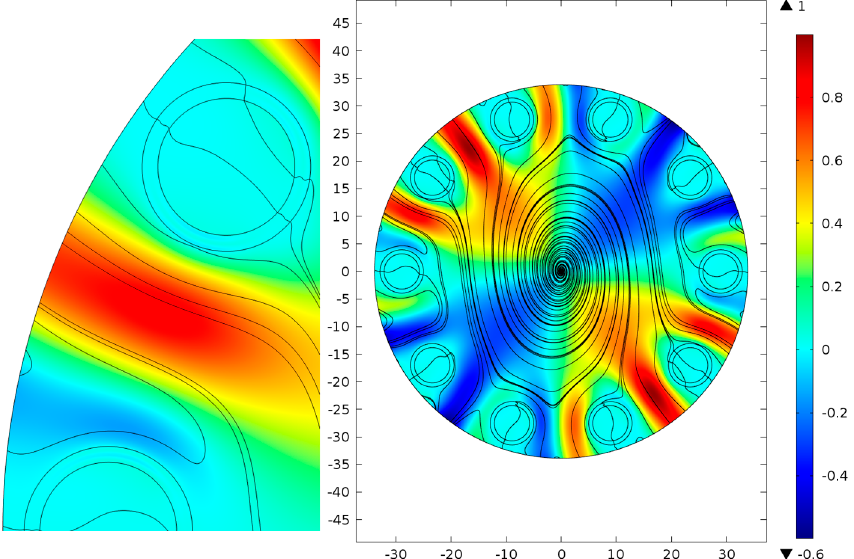
Figure 7. Distribution of the transverse Poynting vector component projection on the radius vector direction in the cross section of a silica glass NCHCF with ten non-contacting cladding capillaries. The streamlines for the transverse component of Poynting vector (black lines).